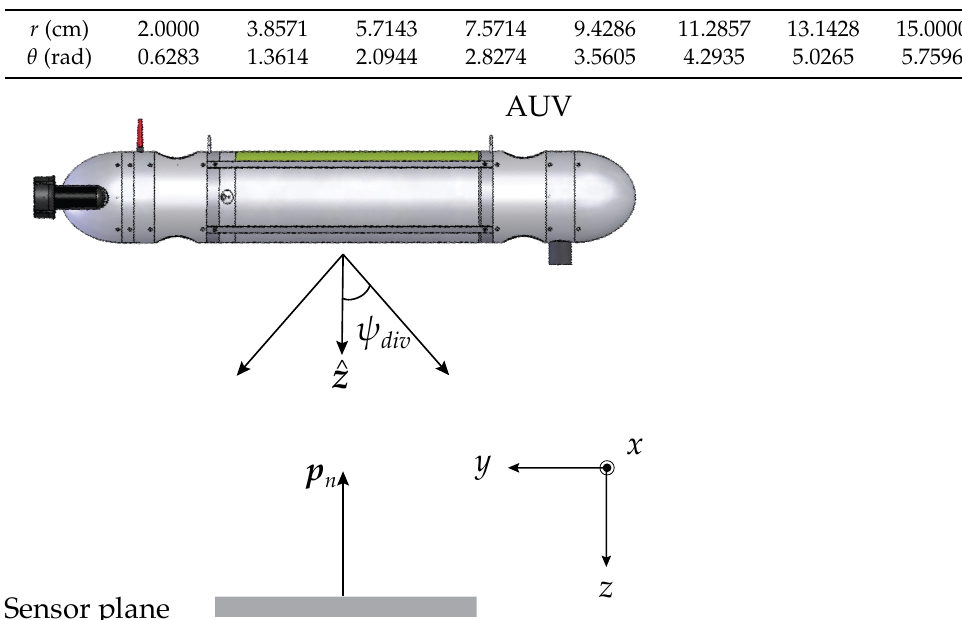
Figure 16. Diagram of AUV communicating with a fixed receiver using a divergent optical